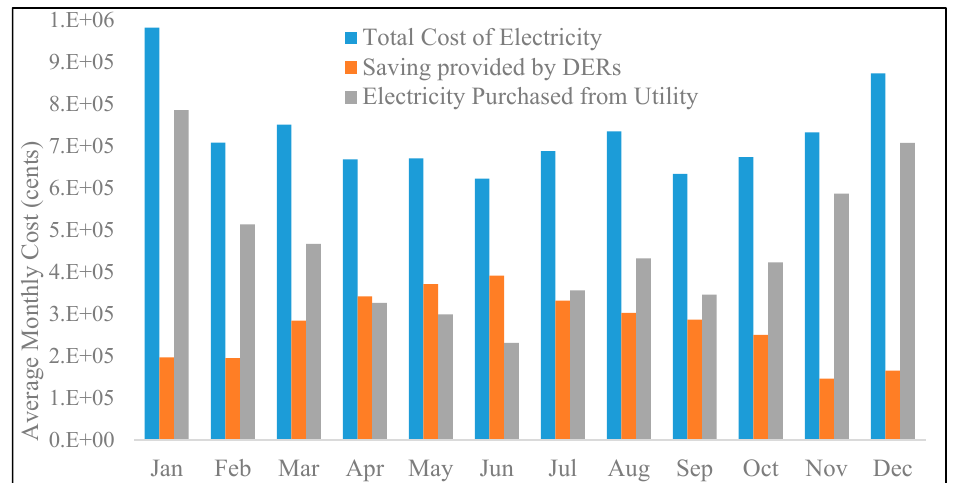
Figure 21. Average monthly cost of electricity for 80 homes and savings provided by DERs.